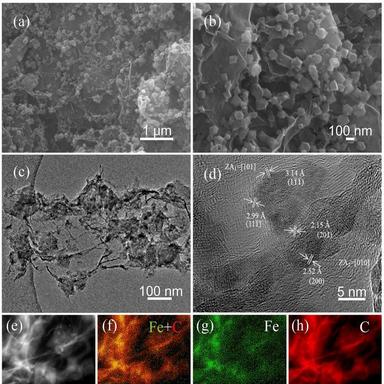
a, b) SEM at low and high magnifications, c) TEM and d) high-resolution TEM images of Fe3C/rGO(5 ml). e-h) STEM images of Fe3C/rGO(5 ml) with corresponding EDS elemental mappings of Fe and C.